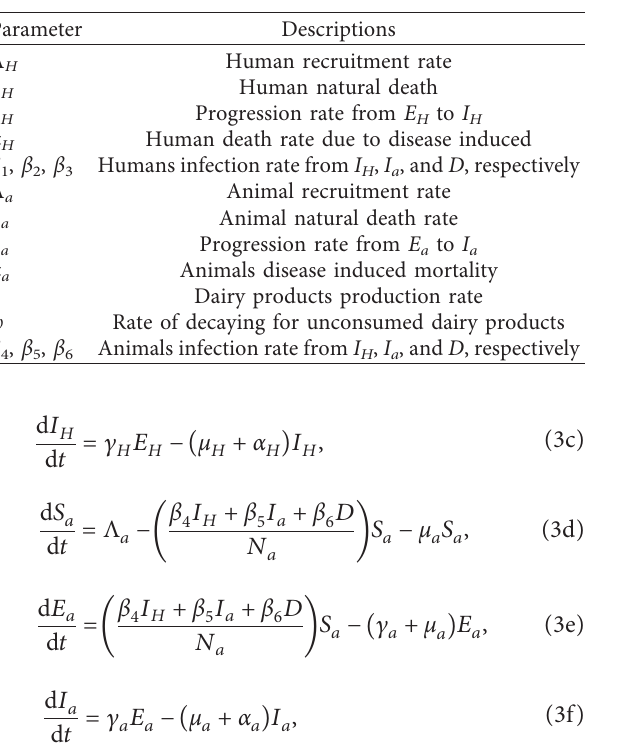
Table 2: Parameters’